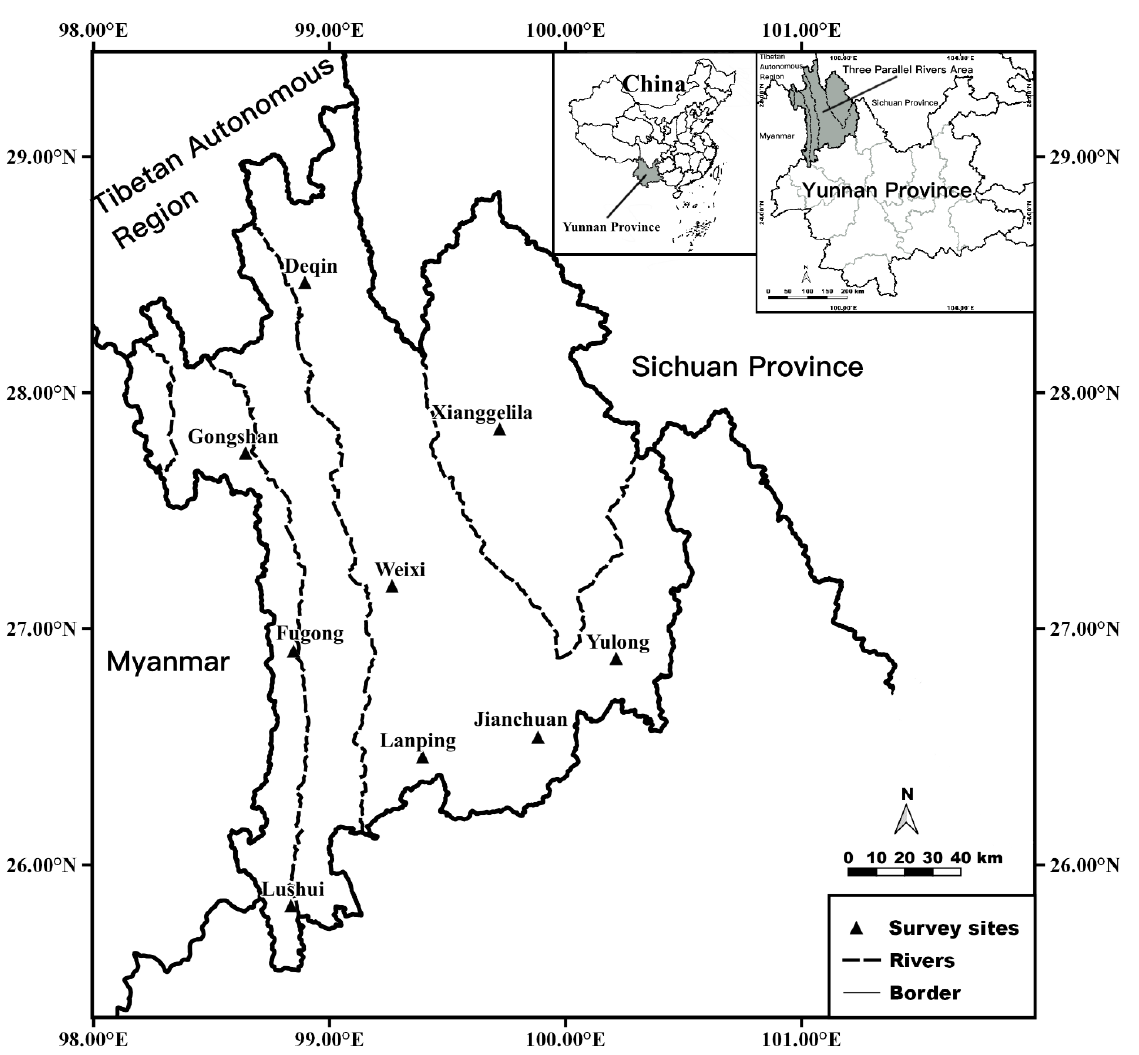
Figure 1. Geographical location of Three Parallel Rivers Area and nine survey sites in northwest Yunnan of China (2001 – 2015).